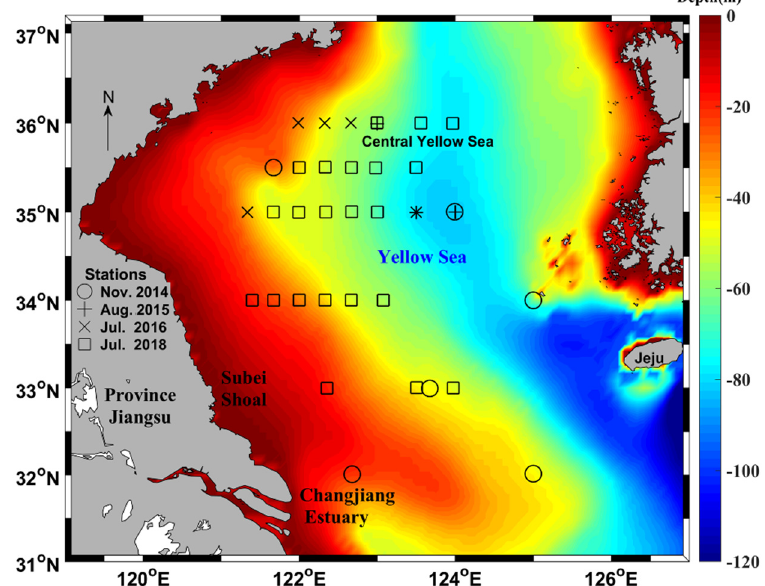
Figure 1. Locations of the sampling stations collected in the SYS during November 2014, August 2015, July 2016, and July 2018.